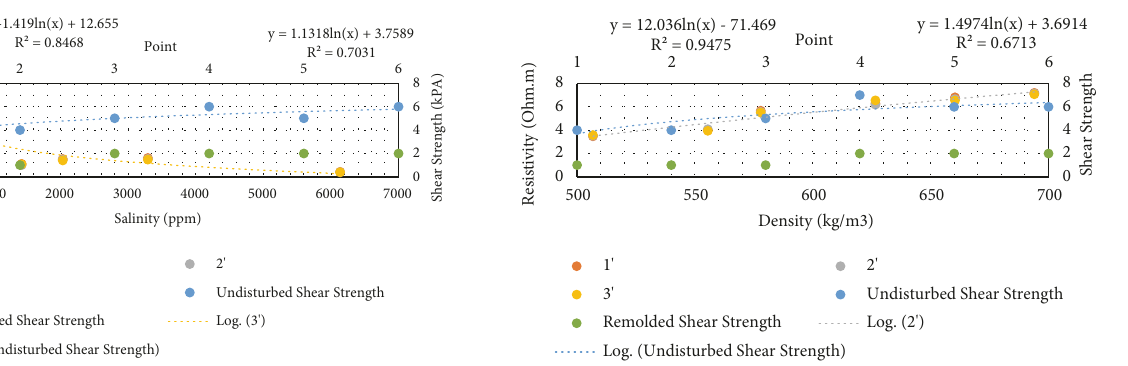
Figure 6: Soil Resistivity and soil shear strength vs soil